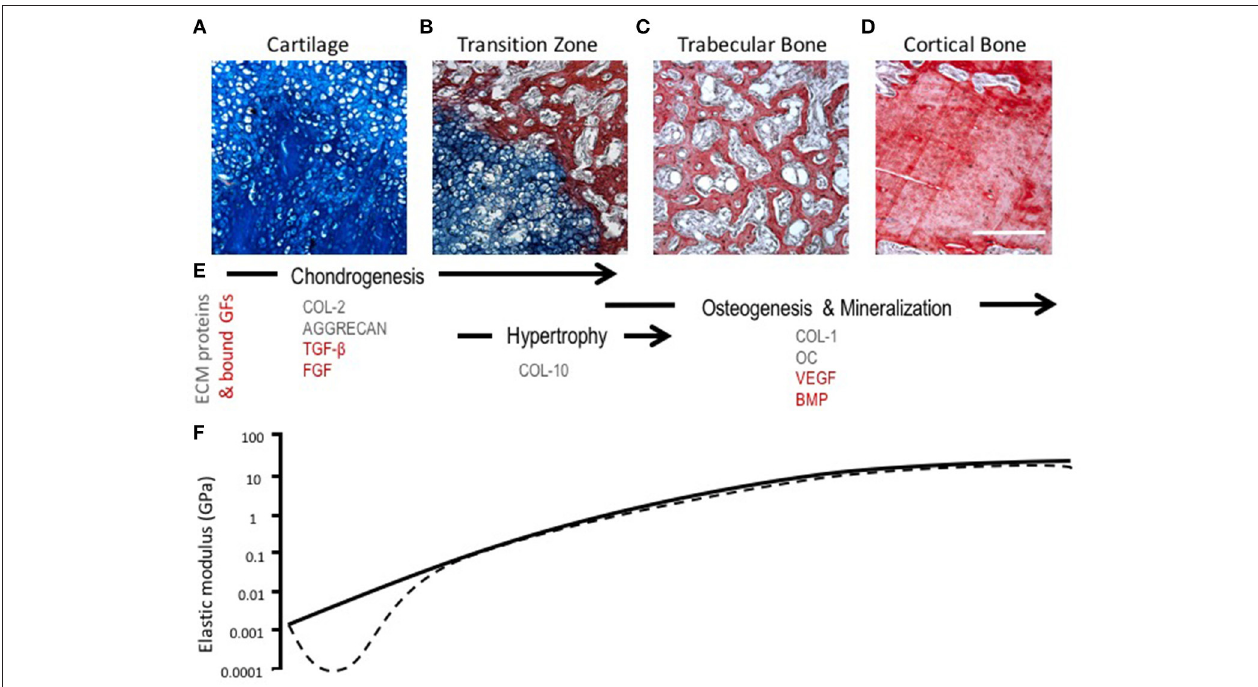
FIGURE 3 | Morphological, compositional, and mechanical changes during endochondral ossification (EO). (A–D) HBQ histology (blue = cartilage, red = bone) of representative tissues from a murine fracture callus throughout stages of healing: (A) cartilage, (B) transition zone, (C) trabecular bone, and (D) cortical bone. Scale bar = 200 µ m. (E) Tissue matrix components and matrix-bound growth factors corresponding to the location and phases of EO ( Chintala et al., 1994; Shen, 2005; Eyre et al., 2006; Martel-Pelletier et al., 2008; Maldonado and Nam, 2013; Martino et al., 2013; Tampieri and Sprio, 2016; Tomlinson et al., 2016 ). (F) Log scale difference in elastic modulus of human samples corresponding to each tissue matrix listed above. Solid line represents normal ossification, dotted line accounts for the initial decline in elastic modulus (osteoarthritis model) ( Ashman and Jae Young Rho, 1988; Rho et al., 1993; Mente and Lewis, 1994; Silver et al., 2002; Pal,